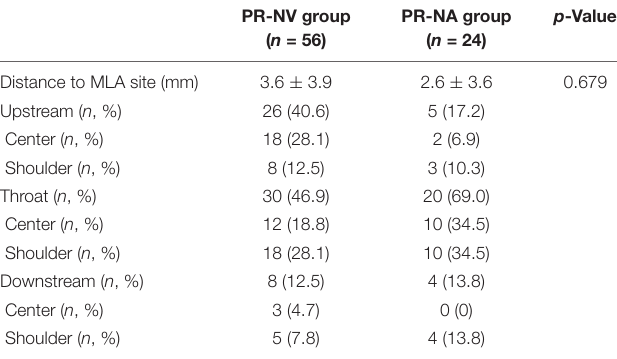
TABLE 3 | Location of plaque